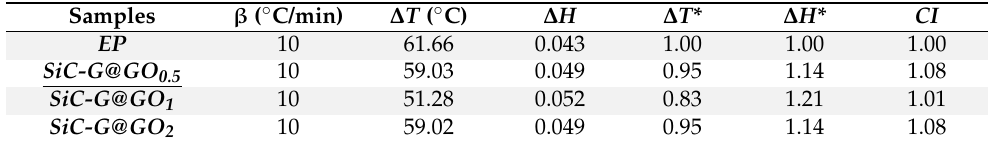
Figure 10. DSC thermograms of the neat EP and EP-based composite coatings obtained at a heating rate of 10 °C/min. Table 1. Cure characteristics of the neat EP and EP-based composite coatings.